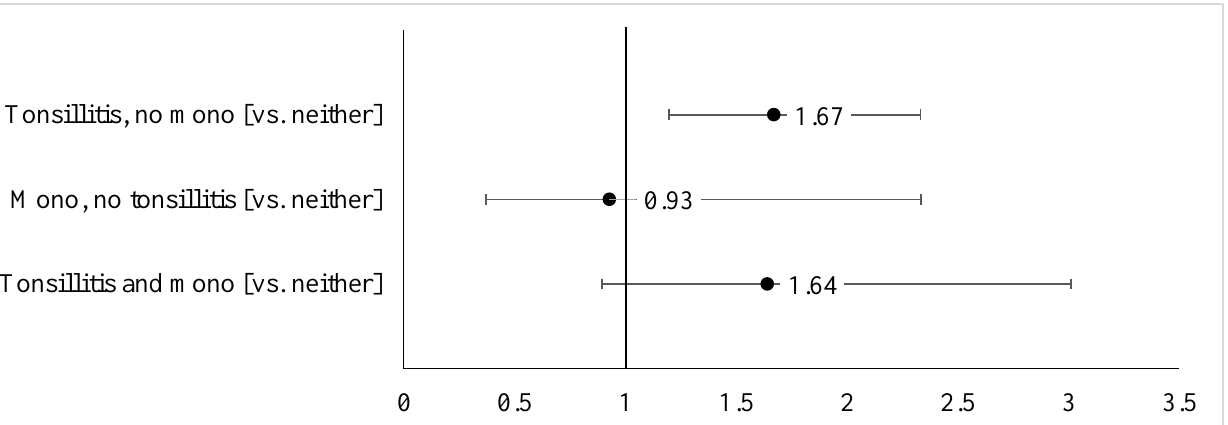
Table 3. Multivariable associations between childhood infections and age at menarche (years) (N = 352). Childhood Infections, β 95% CI Adjusted Mean Age Cumulative Neither tonsillitis nor mono ref. 13.2 Figure 1. Adjusted associations of childhood adversity, cumulative and individual indicators, with early age at menarche Tonsillitis, no mono − 0.73 − 1.26, − 0.20 (<12 years), relative risk ratios, and 95% confidence intervals. Notes: Models for cumulative childhood adversity indicators Mono, no tonsillitis 0.22 − 0.69, 1.16 included complete responses for each of the seven adversity questions (N= 343). Models for individual childhood adver- Tonsillitis and mono 0.45 − 0.44, 1.34 sities included complete responses per indicator (range: N = 373 to 388); reference endorsed vs. not endorsed. All models adjusted for age at interview, race/ethnicity, education, and language dominance.